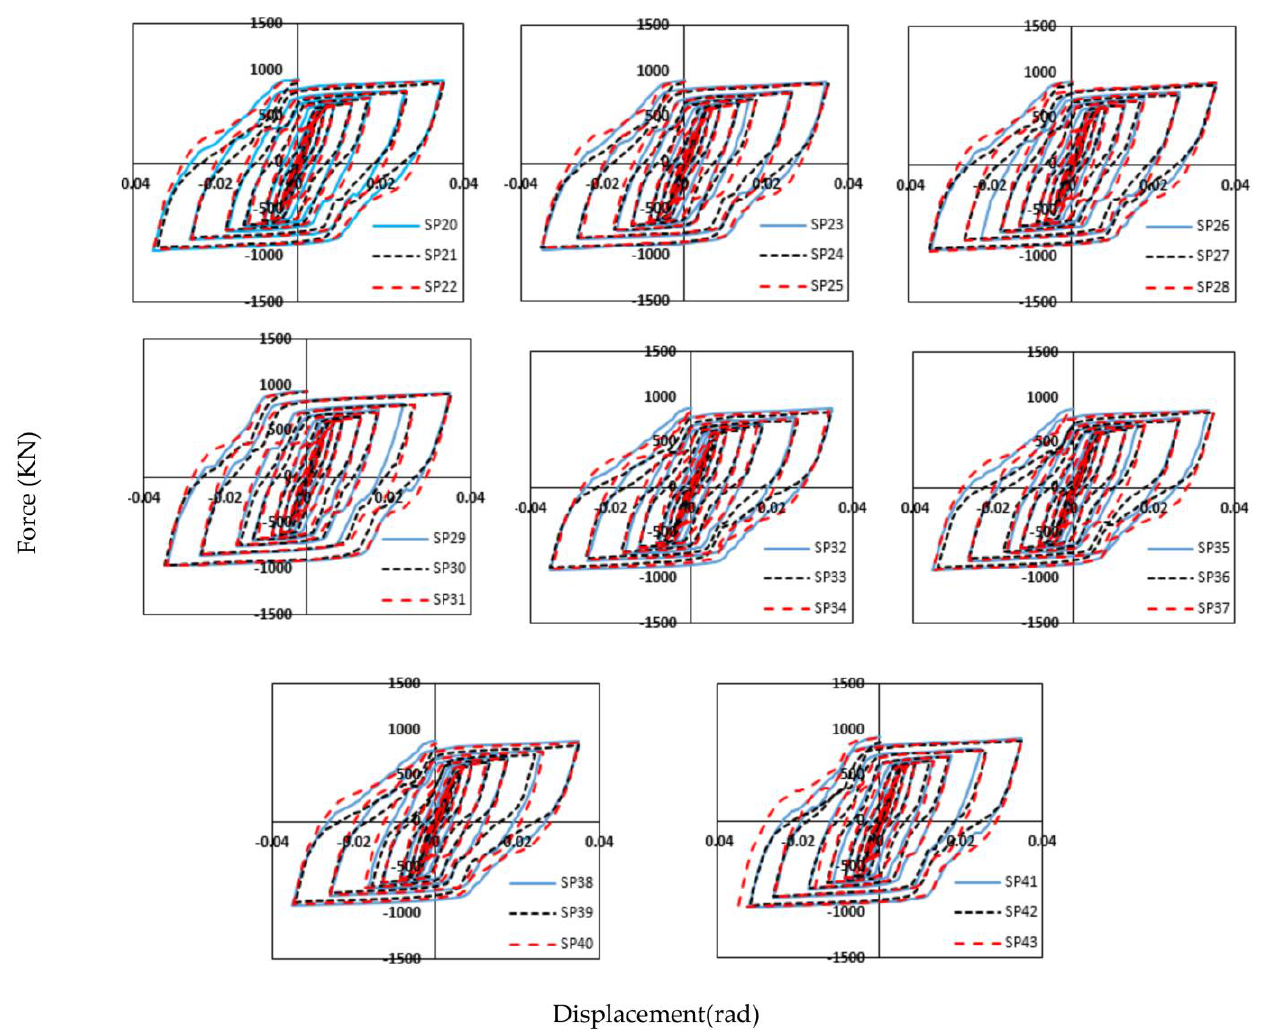
Figure 11. Force – displacement